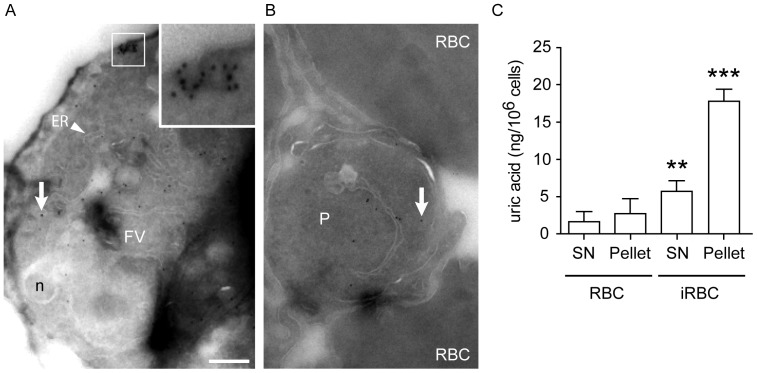
Immunolocalization of uric acid in P. falciparum cytoplasm.(A and B) Immunogold staining of intravacuolar P. falciparum demonstrates cytoplasmic distribution of precipitated uric acid. Arrows mark representative uric acid precipitates in the cytoplasm of iRBC. Aggregates of uric acid are also detected at the parasite periphery (A, inset). One hundred sections of labeled parasites, which included >70 parasitophorous vacuoles, were analyzed. RBC, uninfected erythrocytes; ER, endoplasmic reticulum; FV, food vacuole; n, nucleus. Bar is 200 nm. (C) Purified intact parasitophorous vacuoles were obtained from infected erythrocytes at the schizont stage (iRBC) using saponin treatment. After low-speed centrifugation, the purified parasite fraction was collected as a pellet. Pellets were lysed and ultracentrifugation was performed to obtain supernatant (SN) and pellet fractions. Uninfected erythrocyte (RBC) lysates were processed in parallel. Quantitation of uric acid was performed using a colorimetric absorbance assay. Data are displayed as mean ± SEM (n = 3 independent experiments; **p<0.01, ***p<0.001 relative to RBC controls).